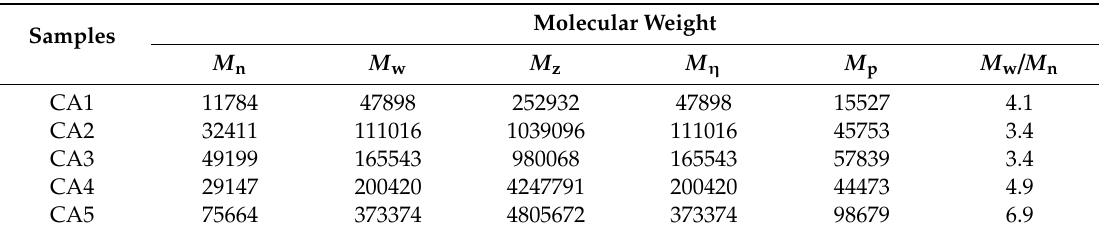
Figure 4. The GPC curves of the derived cellulose samples of CA1–CA5. Table 5. The molecular weight and the distribution of cellulose acetate samples of CA1–CA5 tested by the GPC method.